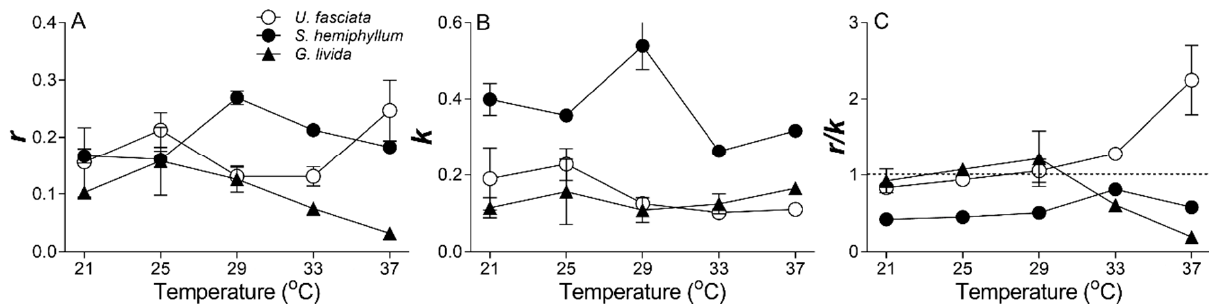
Figure 5. Changes of the photosynthetic capacity ( Φ PS II ) versus time-derived rate constants of repair (( A ); r , min − 1 ) and damage (( B ); k , min − 1 ), and ( C ) r / k ratio with temperature rise for U. fasciata , S. hemiphyllum and G. livida . Points show averages of measurements on three independent macroalga thalli, and error bars show the standard deviations ( n = 3), often within symbols.